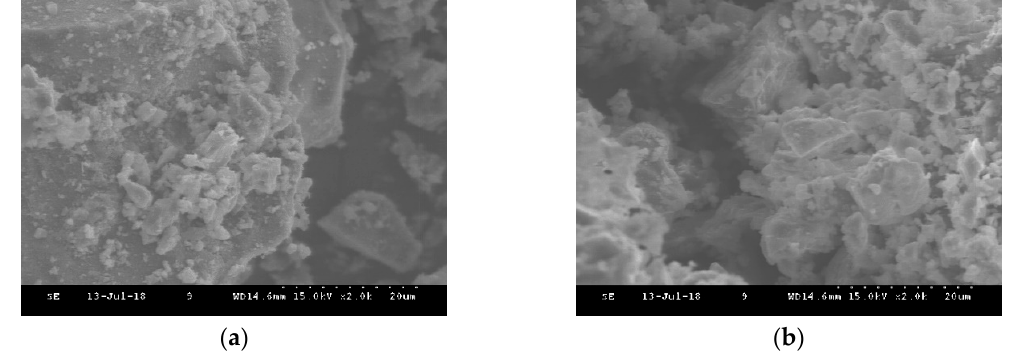
Figure 7. SEM images of the white cement: ( a ) Room temperature; ( b ) 440 ° C. Materials 2020 , 13 , x FOR PEER REVIEW